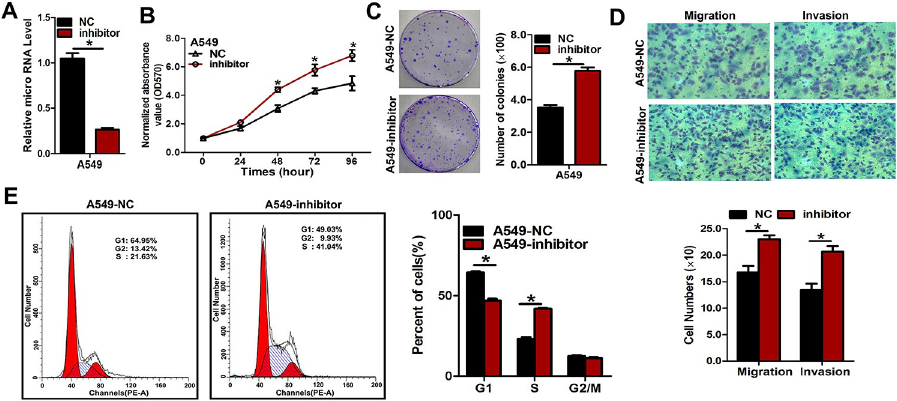
Fig 4. Repression of miR-3607-3p expression significantly promoted cell growth, colony formation, and migration in A549 cells. (A) Quantitative measurement of miR-3607-3p level after the transfection of miR-3607-3p inhibitor (100 ng/L) in A549 cell lines. (B) Cell growth curve measured by MTS after transfection with miR-3607-3p inhibitor (100 ng/L) in A549 cell lines; all OD 570 values were normalized to the starting point (0 hour). (C) Representative images and quantitative results of colony formation were obtained after transfection with miR-3607-3p inhibitor (100 ng/L) in A549 cell lines. (D) Representative images and quantitative results of the Transwell assay were obtained after the transfection of miR-3607-3p inhibitor (100 ng/L) in A549 cell lines. (E) miR-4317 induced cell cycle arrest at G1/S phase. Data are presented as means ± standard deviation from triplicate experiments. � , P <